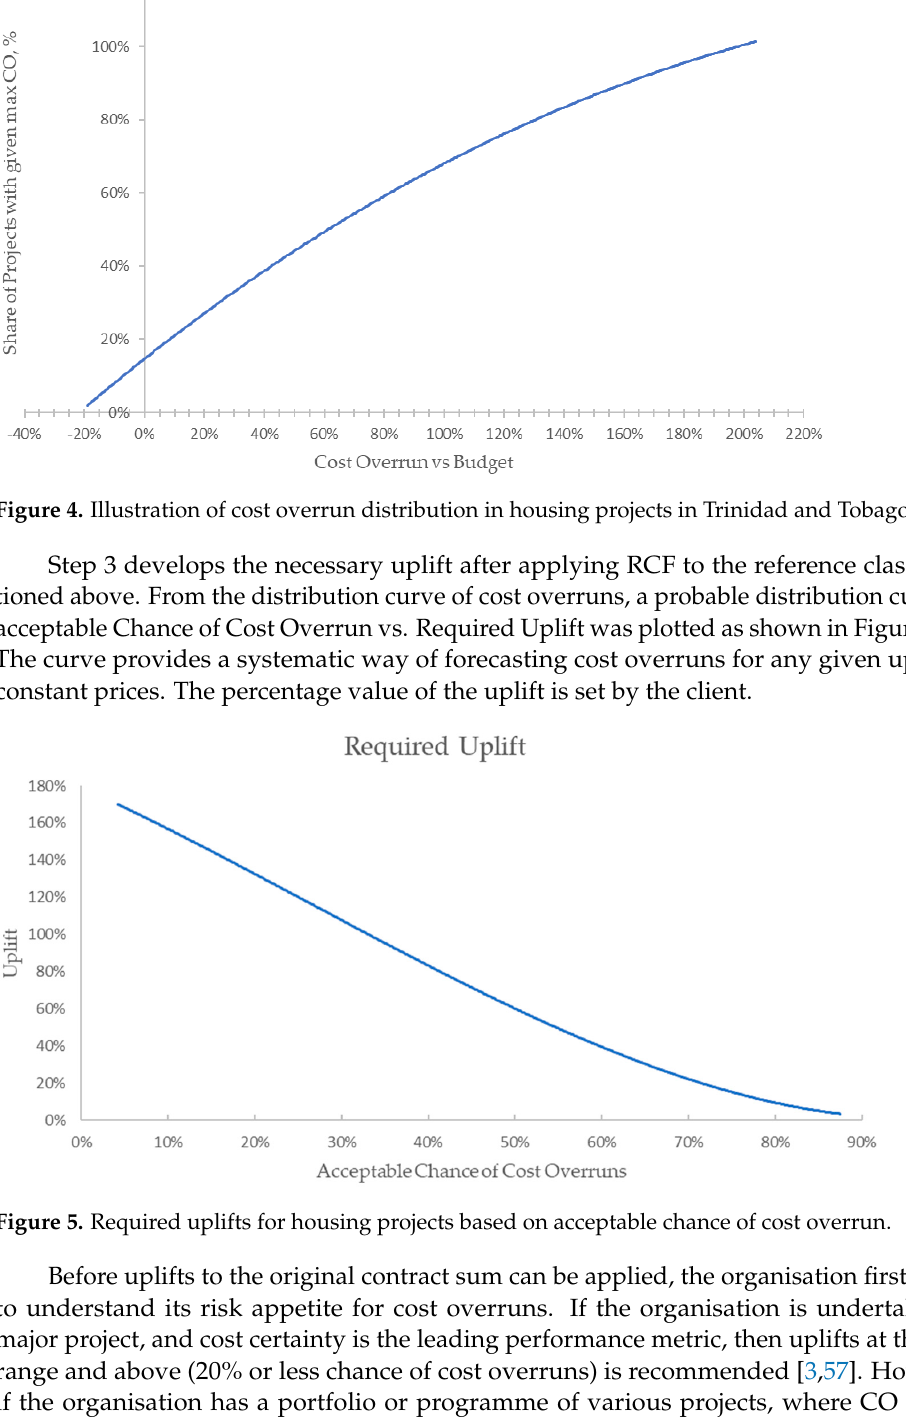
Table 3. Applicable capital expenditure uplifts for the 50% and 80% percentile.